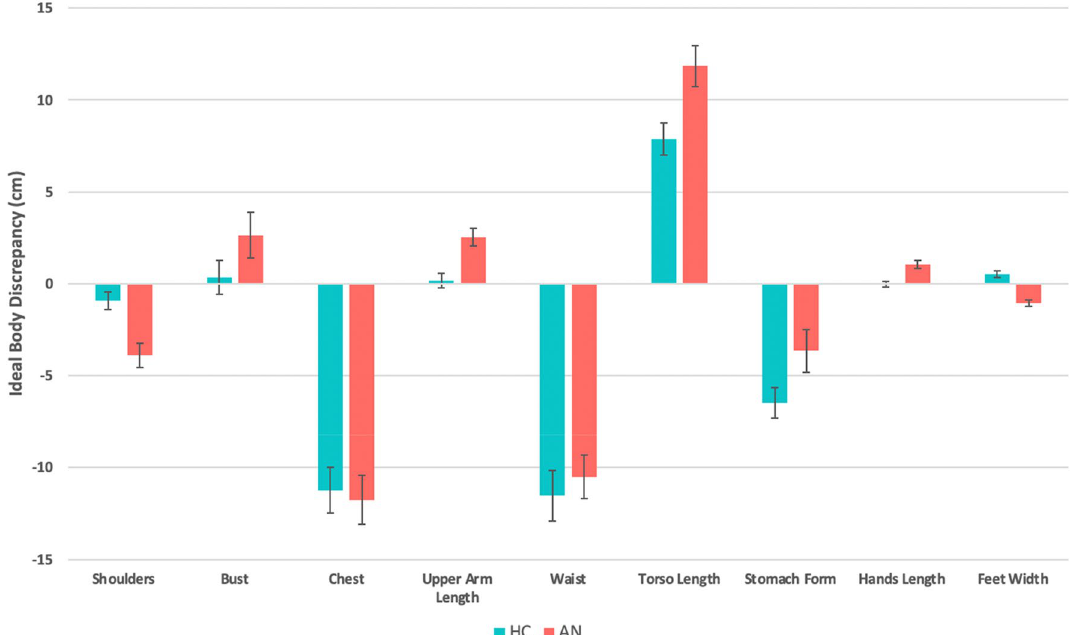
Figure 3. Ideal body discrepancy (ideal body minus actual body measurements (cm)) in female AN and HC groups. Of the total set of 23 body part measurements only those showing significant differences are displayed ( P < 0.05, corrected for multiple comparisons using the Benjamini–Hochberg procedure). Positive values indicate ideal body part size is larger than true body part size, negative values indicate ideal body part size is smaller than true body part size, and zero indicates the ideal and true body part size is the same. Standard errors are represented by error